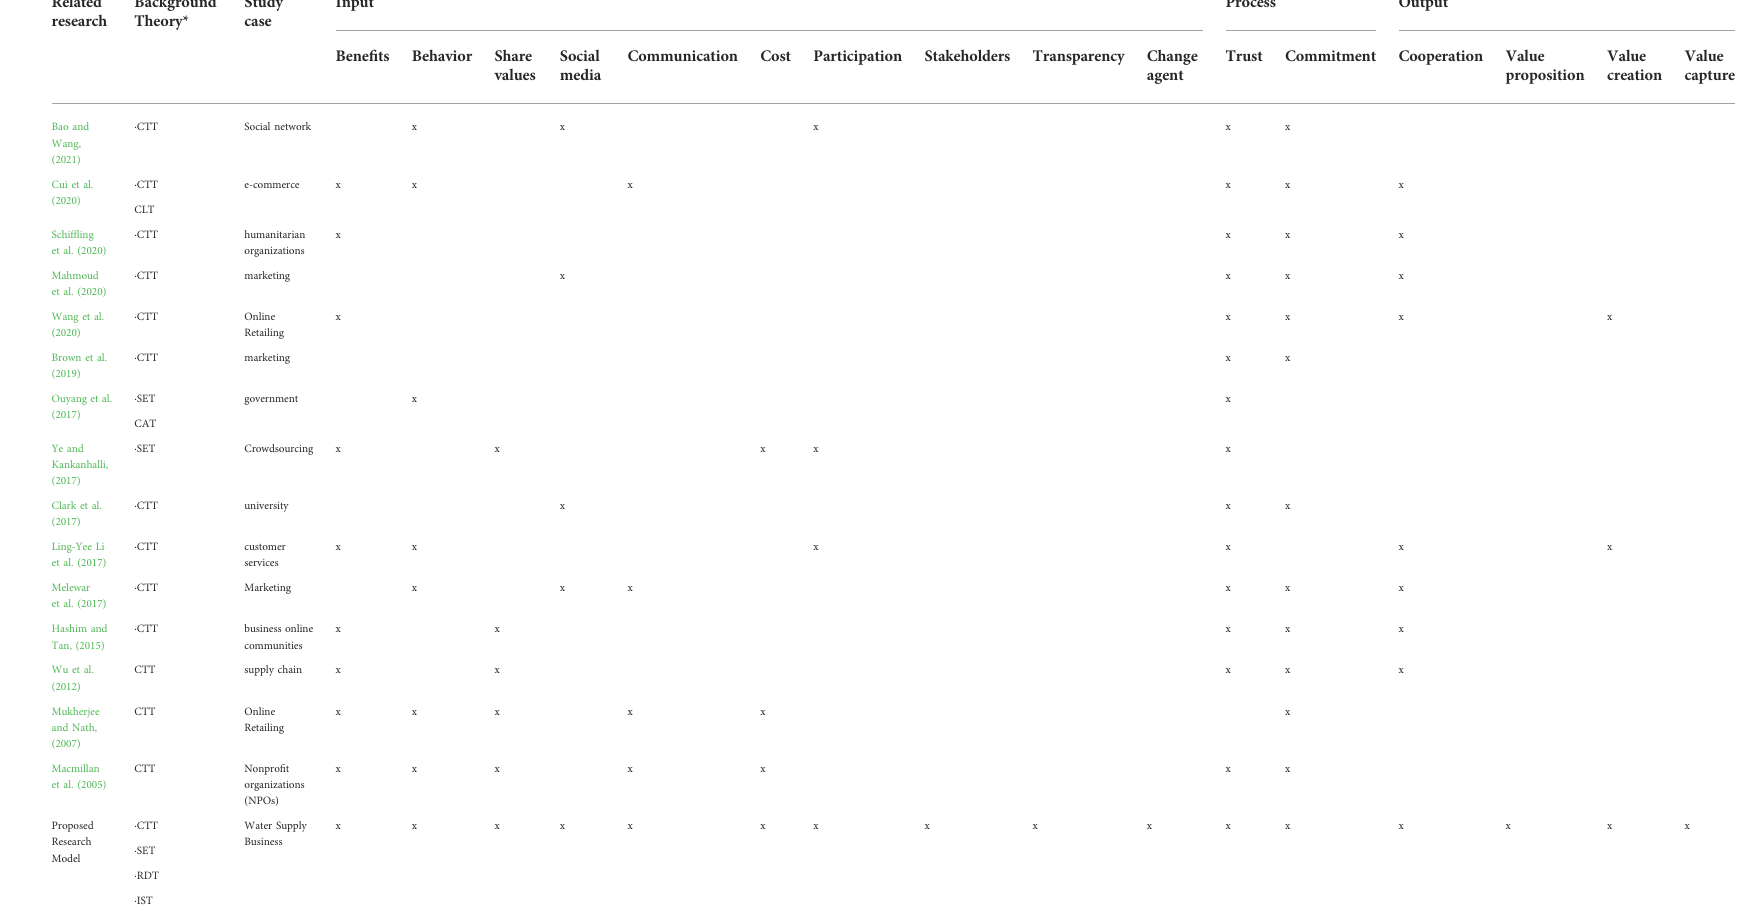
TABLE 2 A review of the literature of relevant articles compared to the proposed research